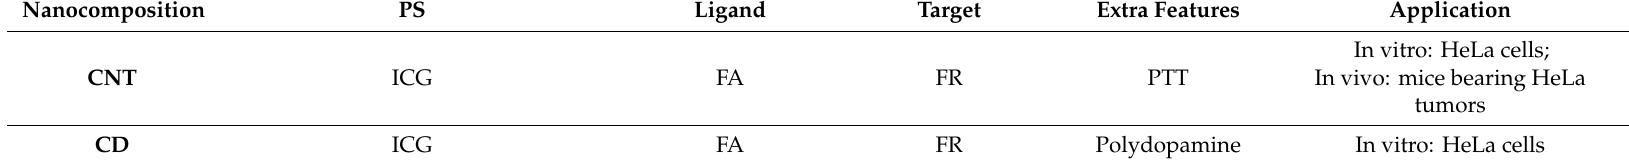
Table 7. Examples of ligand-targeted carbon nanomaterials for